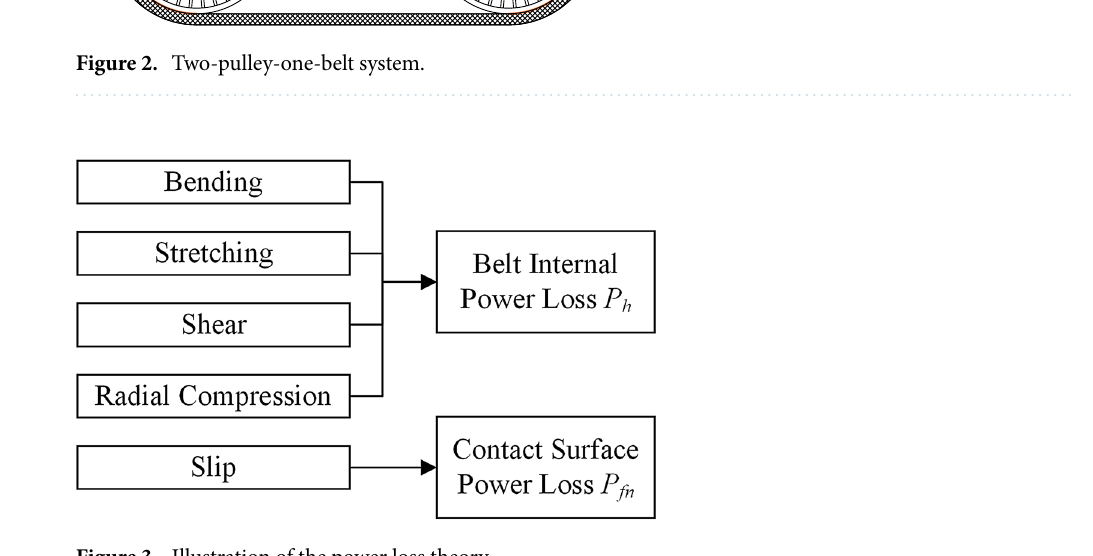
Figure 3. Illustration of the power loss